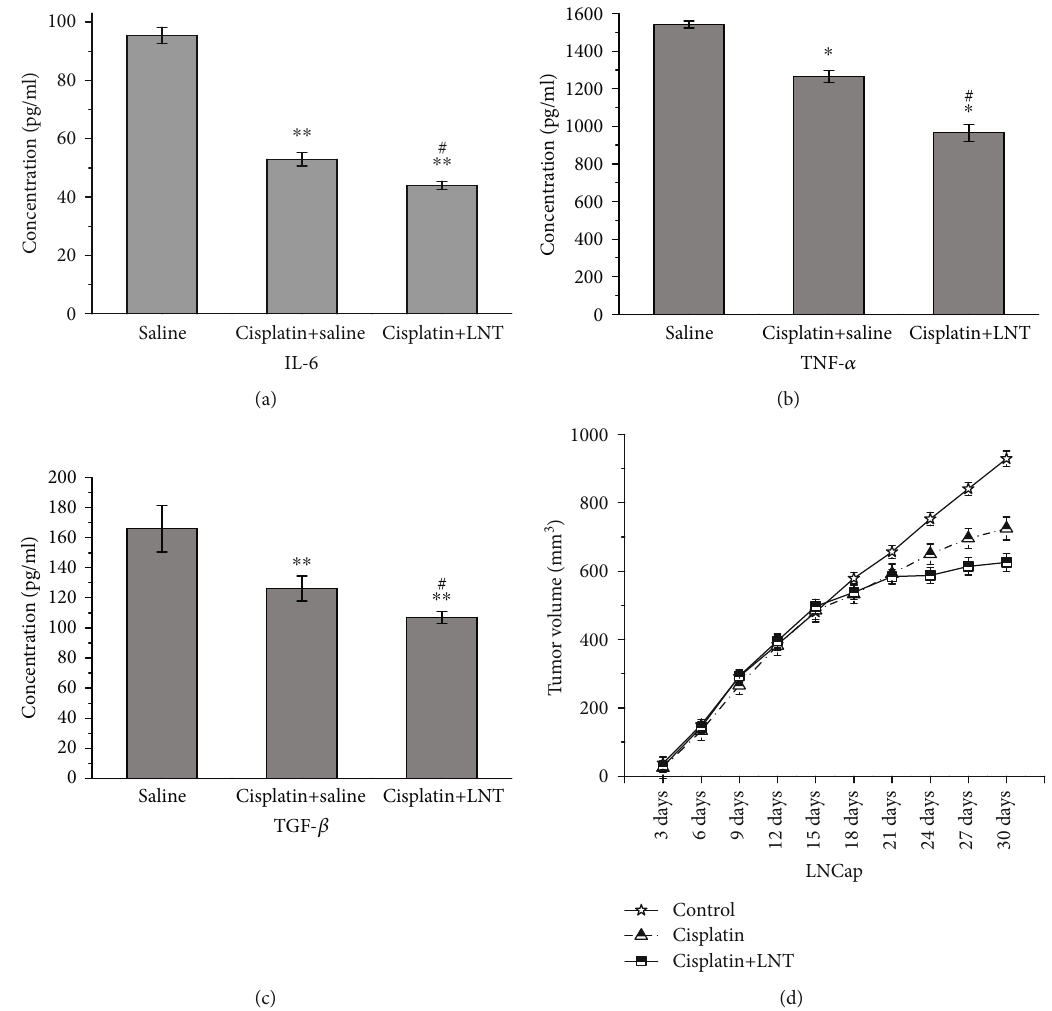
Figure 4: Enhanced inhibitory e ff ect of cisplatin on expressions of IL-6, TNF- α , and TGF- β and tumor growth in mice bearing human prostate tumor xenograft by combination therapy of lentinan and cisplatin. (a – c) It is enhanced by the combined treatment of lentinan and cisplatin that the expression of IL-6 (a), TNF- α , and TGF- β enhanced by the combined treatment for prostate cancer induced by cisplatin. (d) It is enhanced by the combined treatment of lentinan and cisplatin that the inhibition of tumor growth of mice bearing prostate cancer by cisplatin. ∗ P < 0 : 05 , ∗∗ P < 0 : 01 , signi fi cantly di ff erent from the saline group. # P < 0 : 05 , ## P < 0 : 01 , signi fi cantly di ff erent from the cisplatin+saline